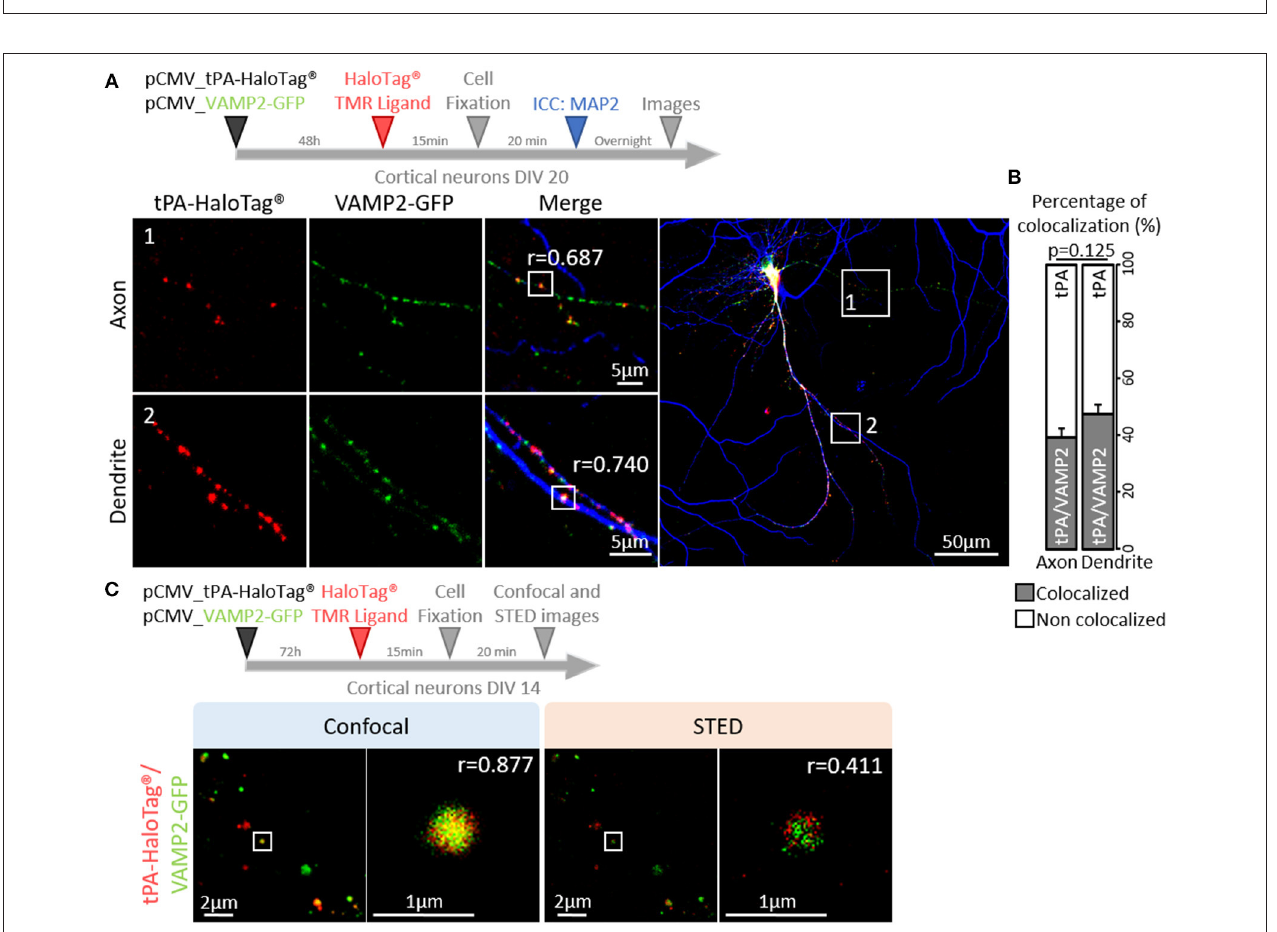
FIGURE 5 | tPA is associated with VAMP2 proteins. (A) Timeline of the experiments. Representative z-stack images of co-transfected cortical neurons (at DIV20) with pCMV_tPA-HaloTag ® (TMR ligand, in red) and pCMV VAMP2-GFP (in green), followed by ICC raised against MAP2 (in blue). tPA-HaloTag ® colocalizes with VAMP2-GFP (exosome) in axons (MAP2-; frame 1) and in dendrites (MAP2 + ; frame 2) with Pearson’s coefficients, respectively: r = 0.687 and r = 0.740. Scale Bar: 5 or 50 µ m (whole neuron). (B) Representative diagrams of the percentages of colocalization between tPA-HaloTag ® and VAMP2-GFP in function of total tPA-HaloTag ® puncta. There are 39% of colocalization in axons and 48% in dendrites ( p = 0.125). (C) Representative images of co-transfected cortical neurons cortical neurons (at DIV14) with pCMV_tPA-HaloTag ® (reveals by TMR ligand, in red) and pCMV_VAMP2-GFP (in green). tPA-HaloTag ® and VAMP2-GFP colocalize, when revealed by confocal and super-resolution microscopy: Stimulated Emission Depletion (STED) with Pearson’s coefficients, respectively: r = 0.877 and r = 0.411. Scale Bar: 2 or 1 µ